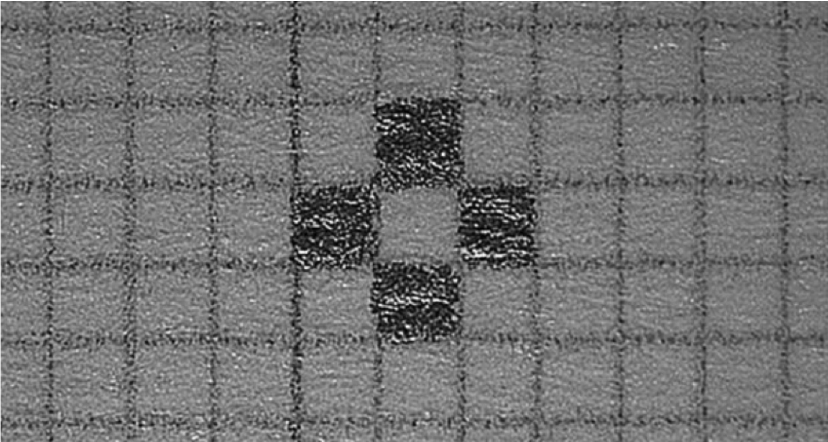
Microgrids model as a microsurgery starter test. Fig. 1: